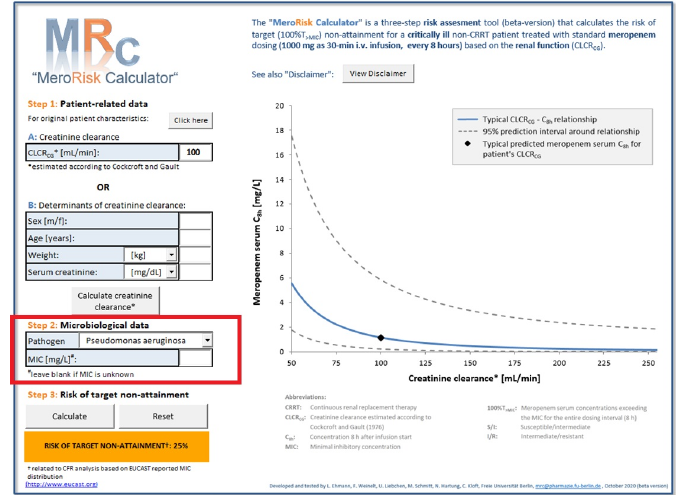
Figure 3. Graphical user interface of the extended MeroRisk-Calculator after risk calculation. Ex- ample for illustration: Patient-related and microbiological data: patients with creatinine clearance of 100 mL/min infected with Pseudomonas aeruginosa and no MIC value available. Red box: ex- tended input possibilities for the microbiological data compared to the first version of the MeroRisk- Calculator. Abbreviations: CLCR CG , Creatinine clearance estimated according to Cockcroft and Gault equation [23]; CRRT, Continuous renal replacement therapy; C8h, Meropenem serum concentration 8 h after infusion start; MIC, Minimum inhibitory concentration.